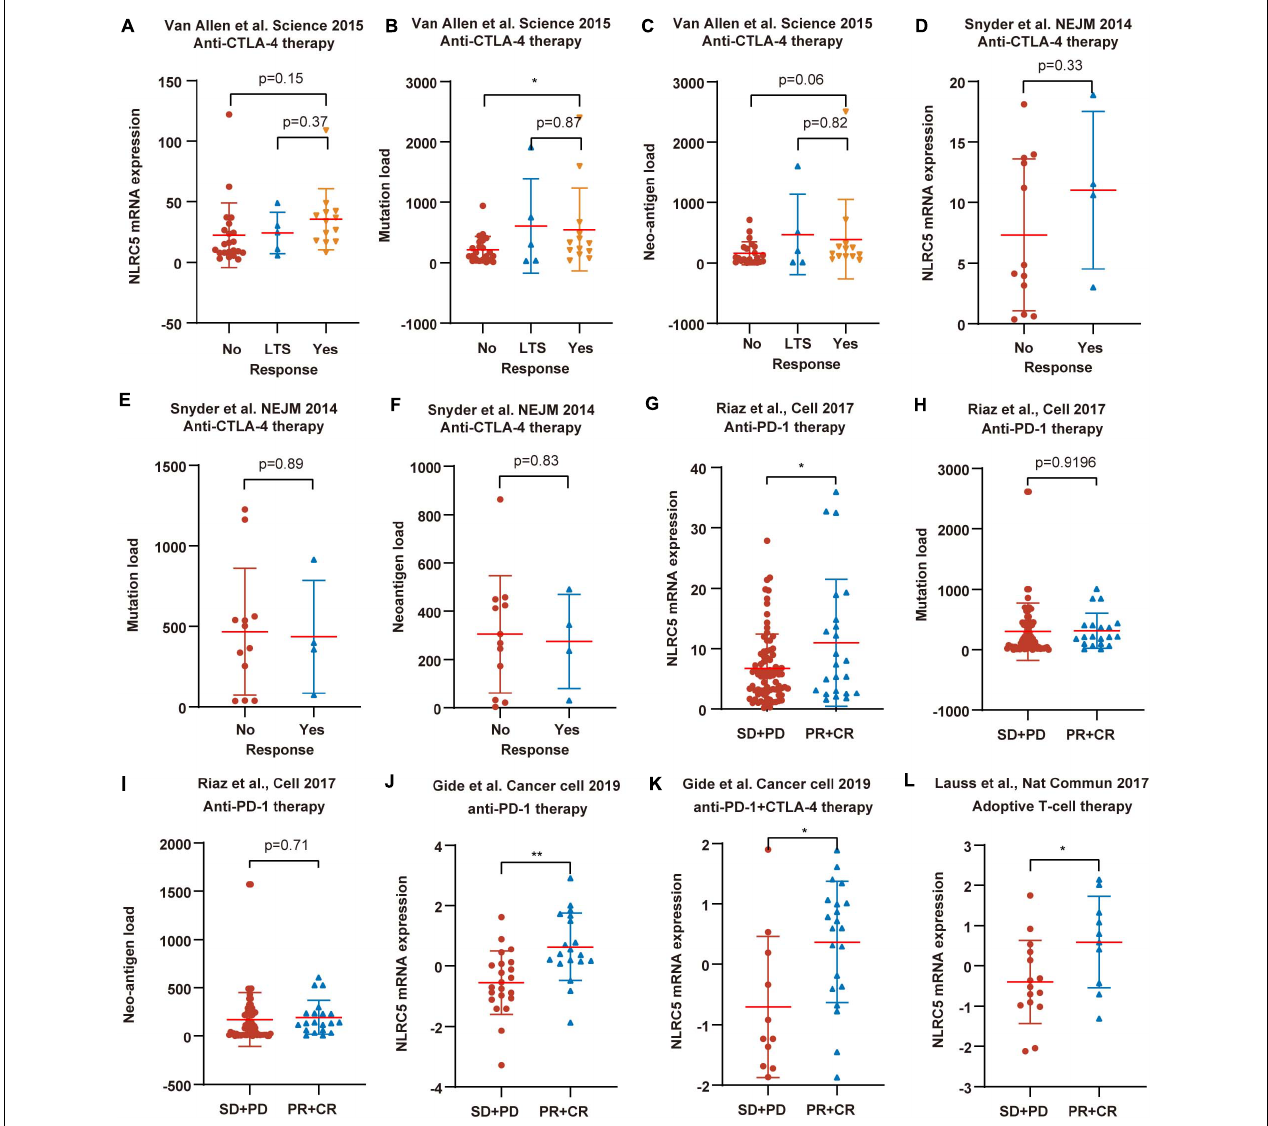
FIGURE 11 | NLRC5 expression is associated with immunotherapy response. (A) Low NLRC5 expression is associated with the decreased immunotherapy response rate in “Van Allen et al., Science 2015.” (B) Low mutation load is associated with the decreased immunotherapy response rate in “Van Allen et al., Science 2015.” (C) Low neo-antigen load is associated with the decreased immunotherapy response rate in “Van Allen et al., Science 2015.” (D) Low NLRC5 expression is associated with the decreased immunotherapy response rate in “Snyder et al., NEJM 2014.” (E,F) Comparison of mutation load/neo-antigen between response and non-response groups in “Snyder et al., NEJM 2014” dataset. (G) NLRC5 expression is lower in the “SD+PD” group than in the “PR+CR” group in “Riaz et al., Cell 2017”. (H,I) Comparison of mutation load/neo-antigen between “SD+PD” and “PR+CR” group in “Riaz et al., Cell 2017.” (J–L) NLRC5 expression is lower in the “SD+PD” group than in the “PR+CR” group in “Gide et al. Cancer cell 2019” and “Lauss et al., Nat Commun 2017.” The type of immunotherapy received by melanoma patients in each dataset is shown. LTS, Long-term survival with no clinical benefit. RECIST categories: CR, complete response; PD, progressive disease; PR, partial response; SD, stable disease. Statistical analysis between every two groups performed by a two-tailed Student’s t -test. P -values were shown as indicated. * p < 0.05, ** p <